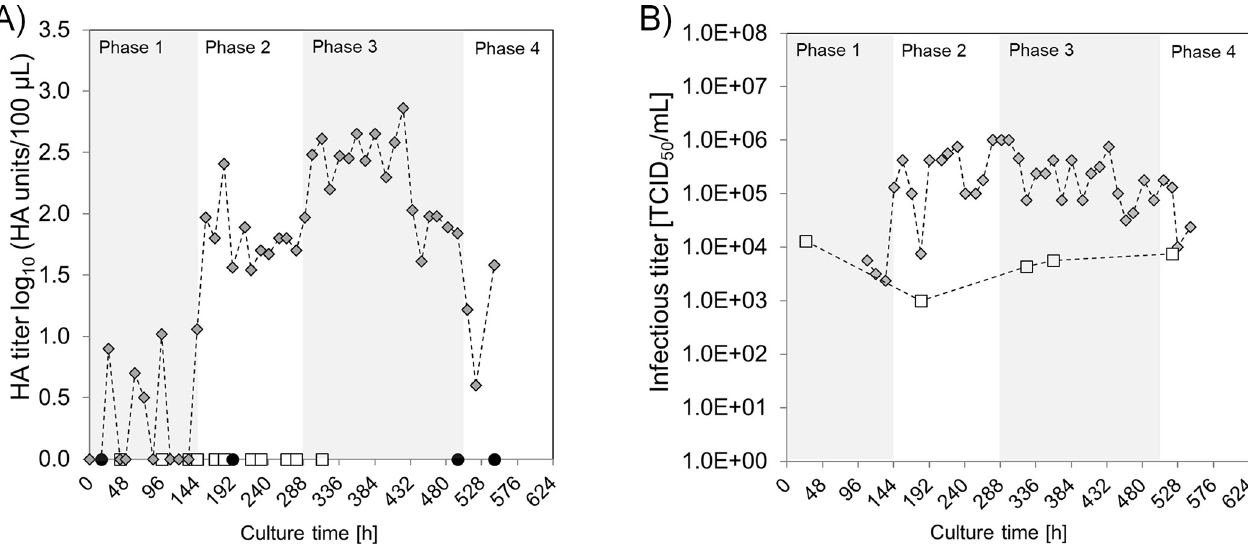
Fig 2. Influenza virus production using suspension MDCK.SUS2 cells (nominal MOI of 0.025, nominal residence time in the PFBR of 20 h) with the continuous tubular bioreactor system. A) HA titers of the PFBR harvest (closed diamonds), in the VS (open squares) and CSTR (closed circles) [19]. B) TCID 50 titers of the PFBR harvest (closed diamonds) and VS (open